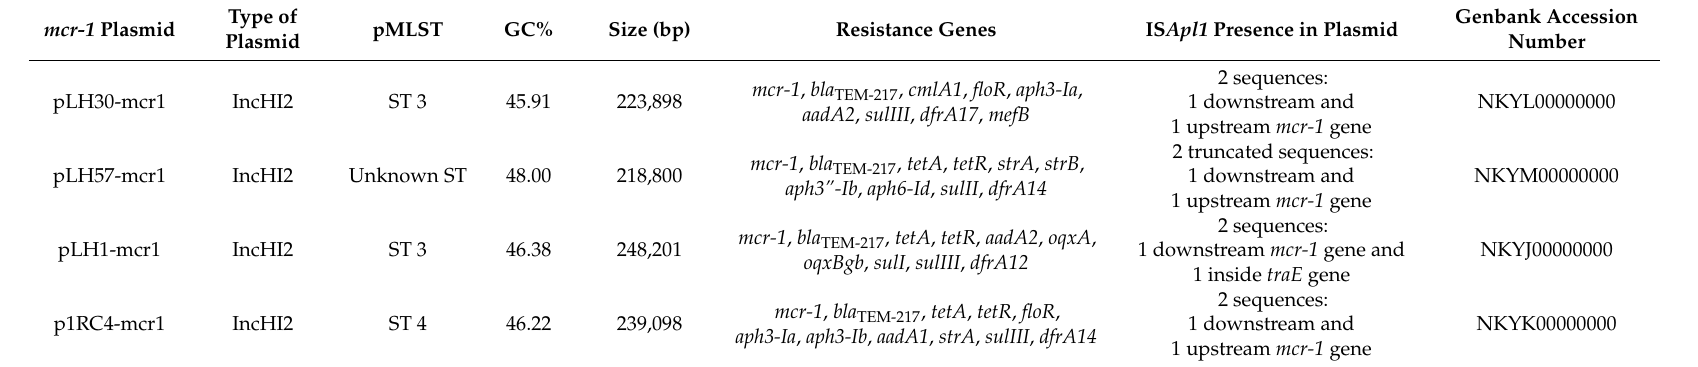
Table 3. In silico analysis of the four sequences of mcr-1